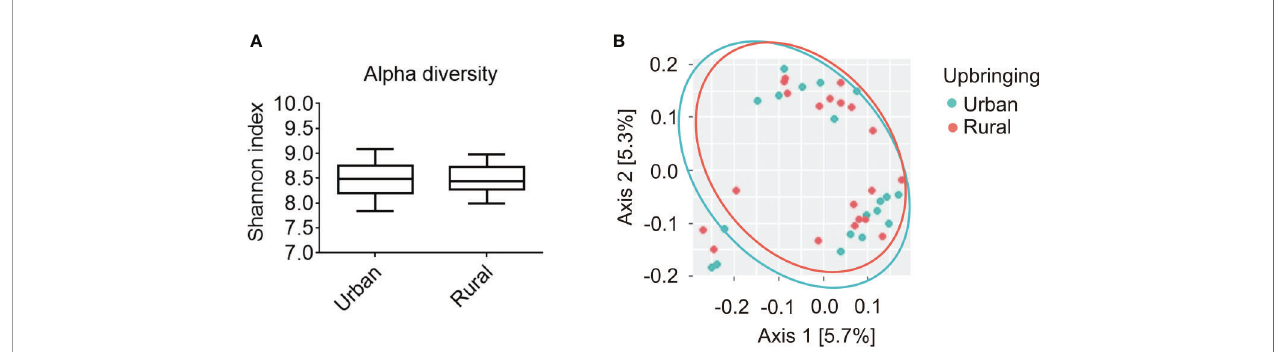
FIGURE 1 | Alpha and beta diversity analysis of the salivary microbiome composition for participants raised in urban areas in the absence of daily animal contact compared to individuals raised in rural areas in the presence of daily contact with farm animals. (A) Shannon diversity index representing richness and evenness within samples was not signi fi cantly different between urban ( n = 20) and rural ( n = 20) populations (Kruskal-Wallis, p = 0.935). Solid line represents the median. Lower box indicates 25th, upper box indicates 75th percentile. 10th and 90th percentile are indicated by lower and upper error bar, respectively. (B) Weighted